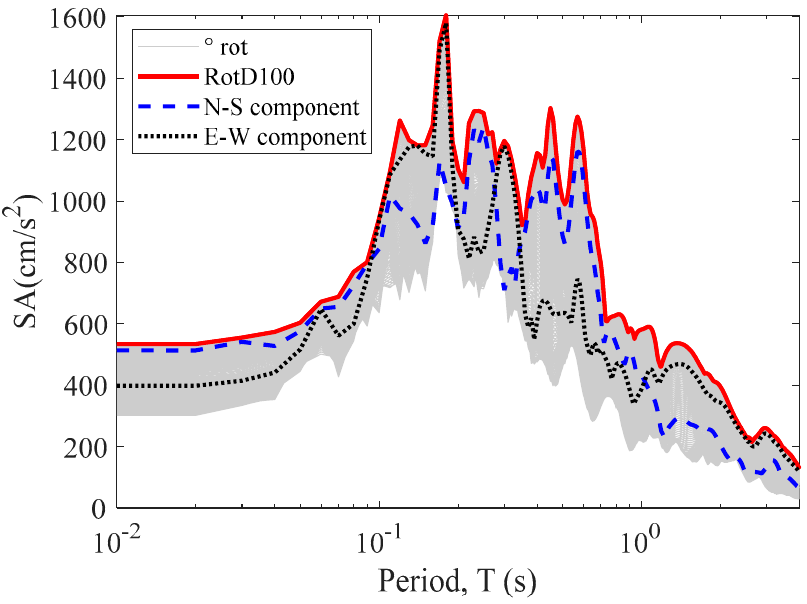
Figure 4. Response spectra of the horizontal as-recorded rotated components and the RotD100 response spectrum for the 2016 Ecuador earthquake ground motion recorded in AMNT station.